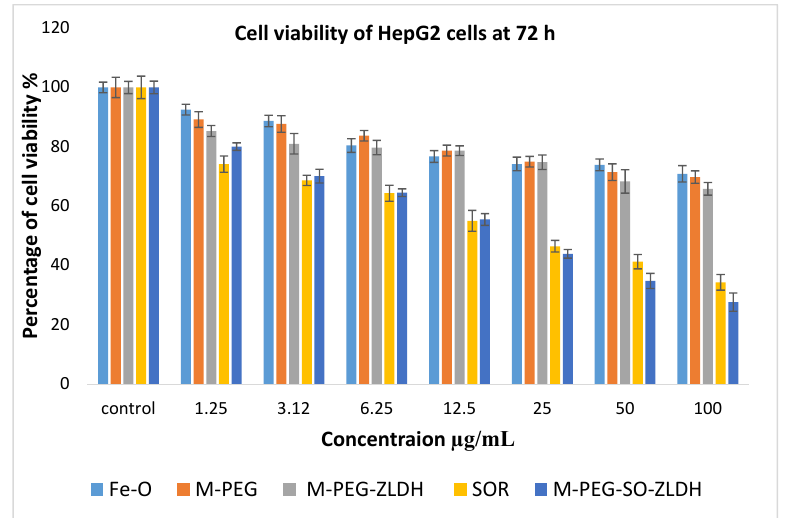
Figure 14. Cytotoxicity assay of Fe–O, M-PEG, M-PEG–ZLDH (the nanocarriers), pristine sorafenib, and M-PEG–SO–ZLDH (the drug delivery nanoparticles) against HepG2 cells at 72 h of incubation. Results were calculated as mean ± standard deviation for n = 3 independent experiments.